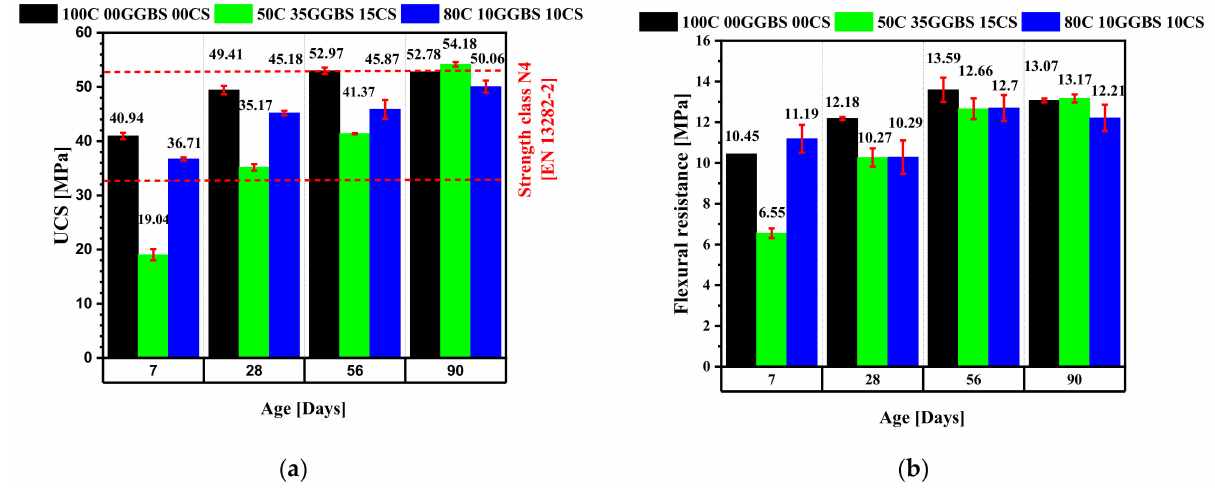
Figure 12. Mix ( a ) compressive and ( b ) flexural strengths at 7, 28, 56, and 90 curing